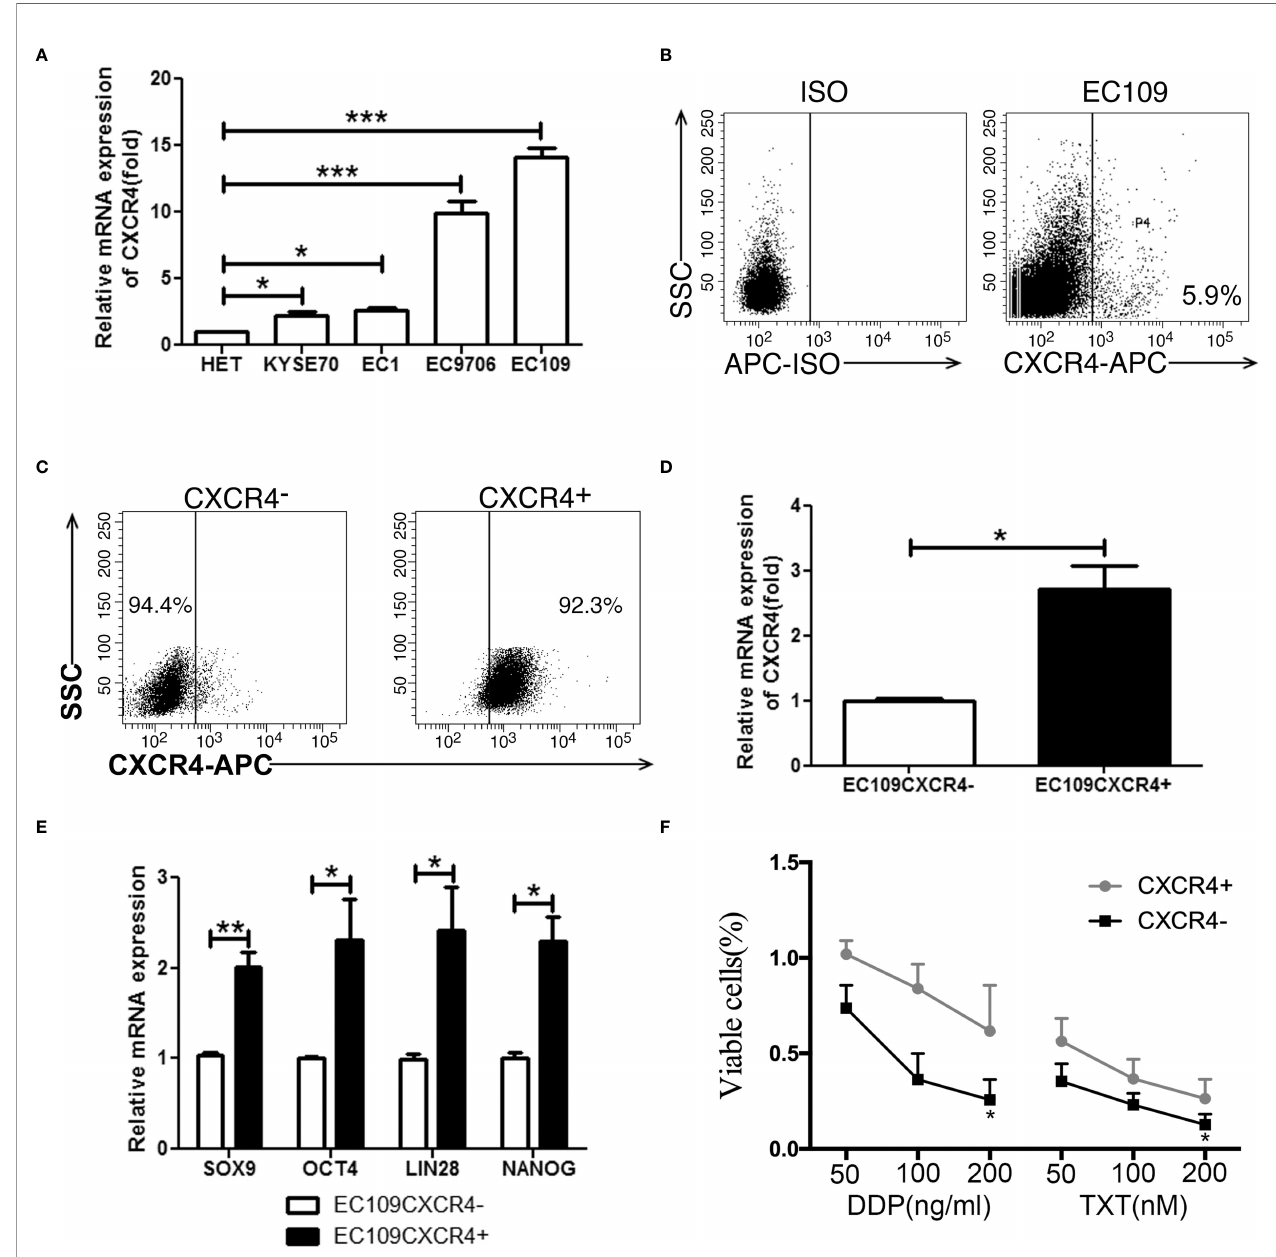
FIGURE 3 | CXCR4 positive cells possessed stem-like properties. (A) The CXCR4 expression was detected by real time PCR in 1 immortalized esophageal cell line (Het-1a) and 4 ESCC cell lines. (B) The expression analysis of CXCR4 was detected by fl ow cytometry. (C) The purity of sorted EC109 cells with or without CXCR4 expression. (D) The expression analysis of CXCR4 was detected by real time PCR. (E) The expression analysis of stemness-related transcription factors (SOX9, OCT4, LIN28, and NANOG) was detected by real time PCR. (F) Cell survival rate was tested by CCK-8 method. *P < 0.05, **P < 0.01, and ***P <